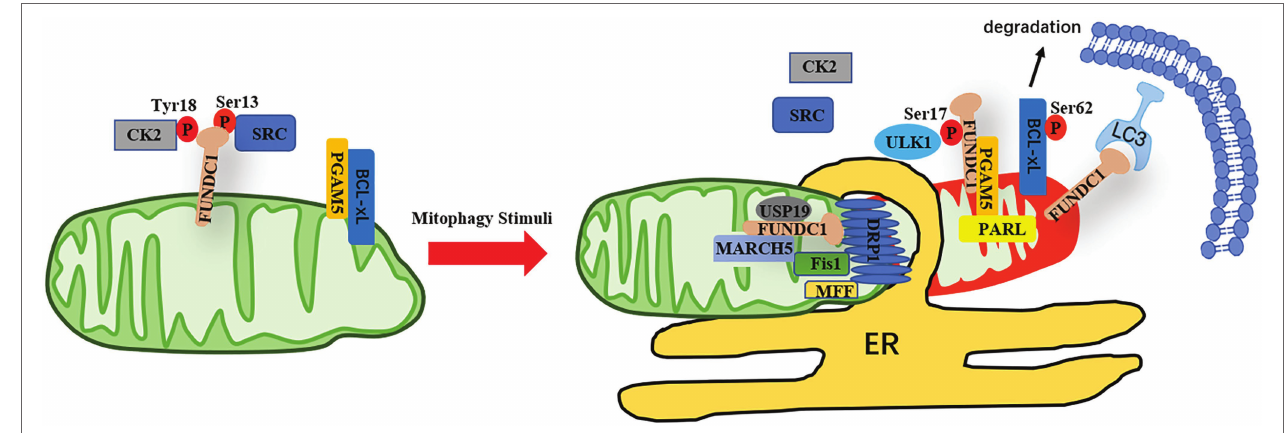
FIGURE 1 | The regulation of FUNDC1-mediated mitophagy. Under normoxic conditions, the activity of FUNDC1 is inhibited due to phosphorylation of FUNDC1 at Ser13 and Tyr18 by CK2 or Src, respectively. The phosphatase PGAM5 dephosphorylates FUNDC1 at Ser13, which is inhibited by Bcl-xL in normal conditions. In response to mitophagy stimuli, Bcl-xL is degraded and PGAM5 is released to dephosphorylate FUNDC1 at Ser13 and the interaction of Src and CK2 with FUNDC1 is reduced, leading to dephosphorylation of FUNDC1 at Tyr18 and Ser13 and phosphorylation of BCL-xL at Ser62. PGAM5 also can be cleaved by PRAL and the interaction between cleaved form of PGAM5 and FUNDC1 is enhanced. Meanwhile, the kinase ULK1 is translocated to mitochondrial to phosphorylate FUNDC1 at Ser17. The protein level of FUNDC1 is regulated by MARCH5, whereas the interaction between FUNDC1 and DRP1 at MAMs is enhanced when FUNDC1 is deubiquitinated by USP19. Altogether, the function of FUNDC1 is regulated by reversible phosphorylation and ubiquitination, favoring segregation of damaged mitochondria and